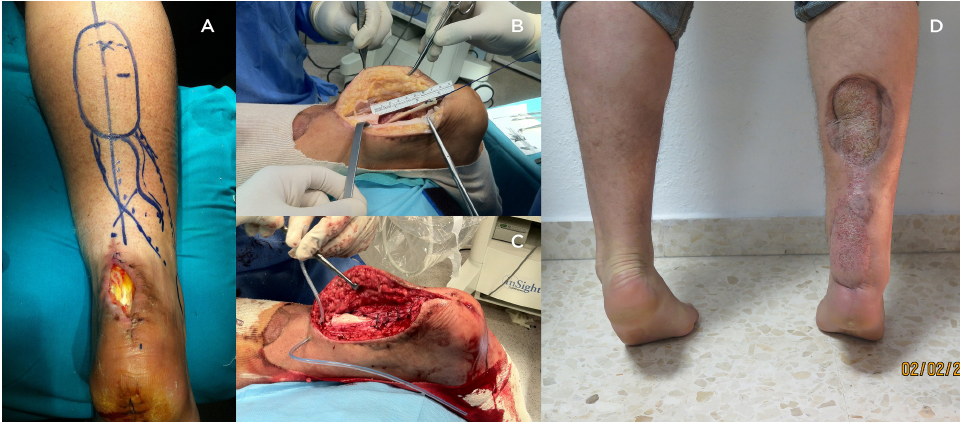
Figure 3. A case of absence of Achilles tendon secondary to an infection of an acute repaired rupture. The patient underwent initial surgery, which included deep debridement, gentamicin-PMMA bead implantation, and intravenous antibiotic therapy, to resolve the infection. Salvage reconstruction was then performed 12 weeks later. ( A ) A soft tissue defect is visible above the Achilles tendon, and a sural flap is planned for coverage. ( B ) Following resection of non-viable tissue, a 9 cm gap in the Achilles tendon was identified. A flexor hallucis longus (FHL) transfer was performed and sutured in place first. ( C ) Intraoperative photograph showing the sutured allograft filling the gap, in conjunction with the FHL transfer. ( D ) Long-term follow-up revealing functional heel-rise and the donor site of the sural flap covered with a skin